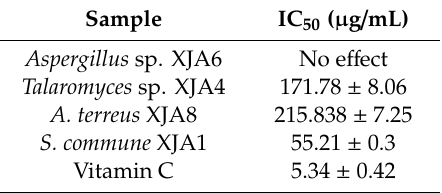
Table 7. Antioxidant activity of ethyl acetate crude extract from selected endophytic